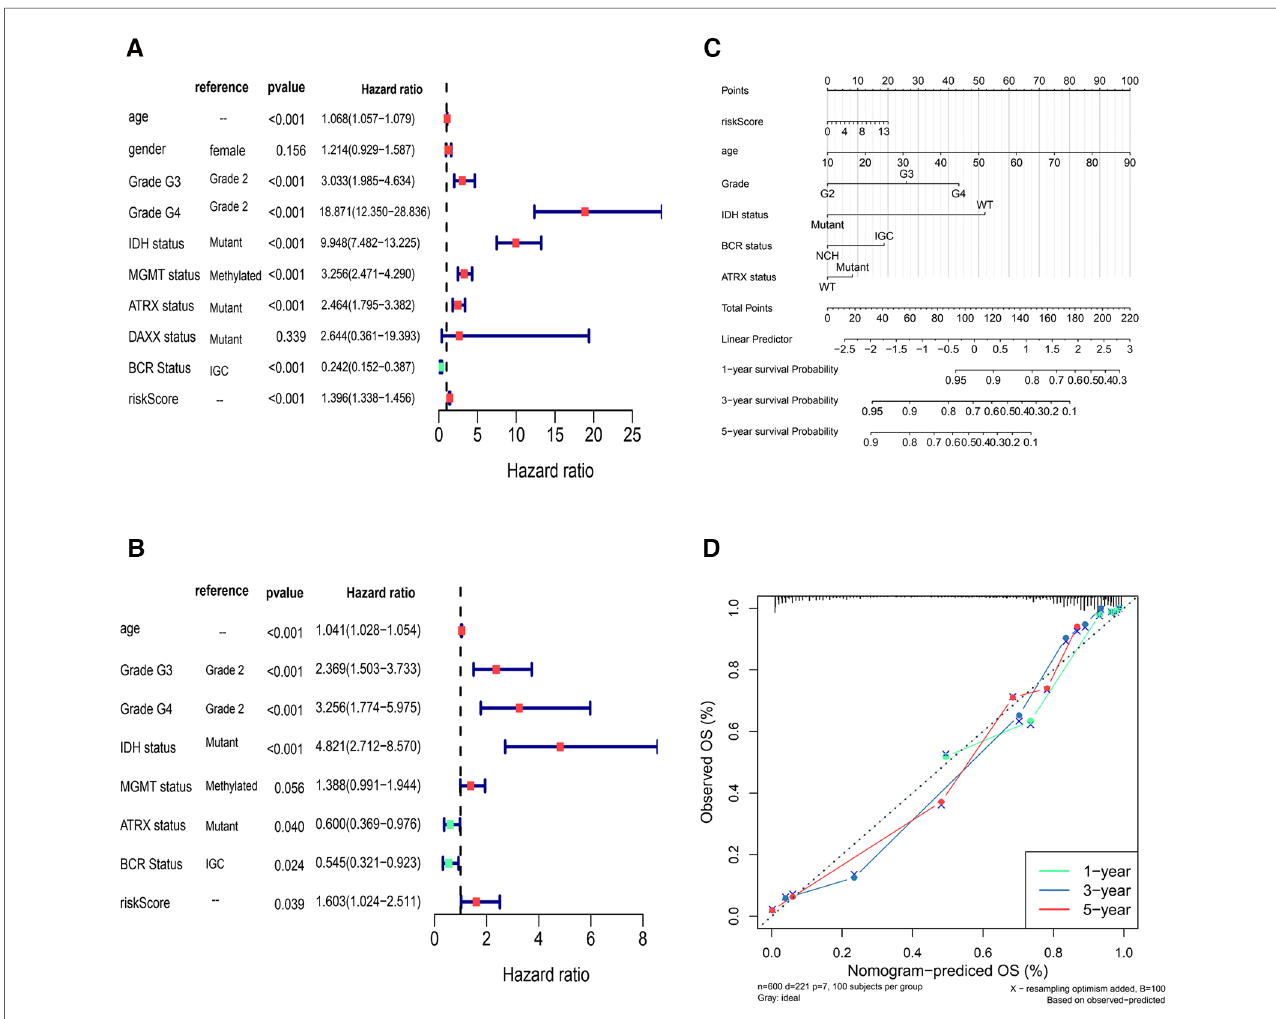
FIGURE 7 Independent prognostic analysis of risk model ( A,B ) univariate Cox and multivariate Cox independent prognostic analysis ( C ) the nomogram in TCGA glioma sample to predict 1, 3 and 5-year survival rate (the C-index was 0.8617) ( D ) the correction curve of